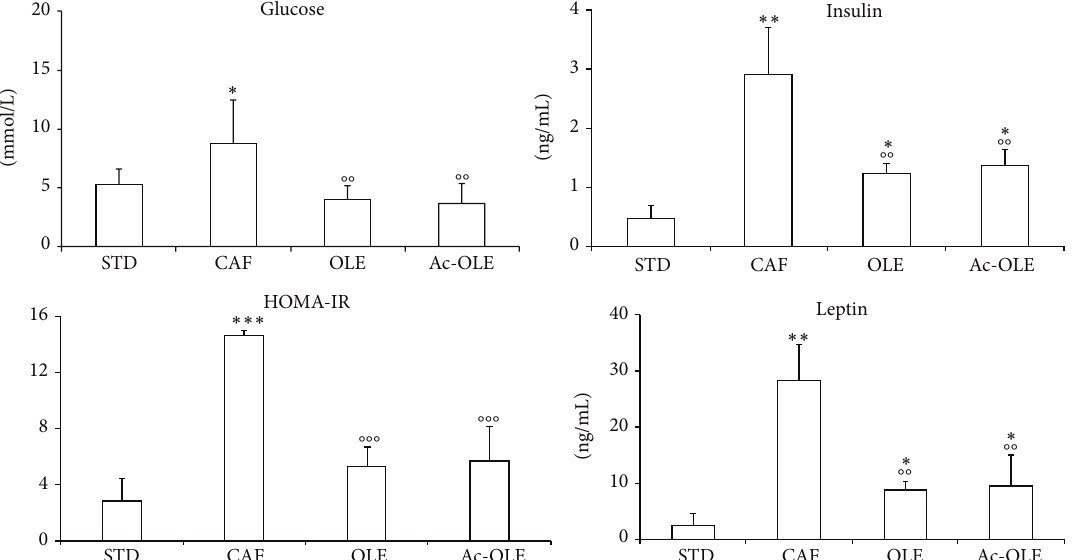
Figure 4: Effects on plasma levels of glucose, insulin, and leptin and evaluation of insulin resistance after treatment with Ole and Ac-Ole. Blood samples were collected as indicated in Methods. Glucose and hormones levels were significantly lower after treatment with Ole and Ac-Ole in animals fed with caf diet. Homeostasis model assessment of insulin resistance (HOMA-IR) was calculated as indicated in Methods. Values are mean ± SD. ∗ 𝑃 < 0.05 , ∗∗ 𝑃 < 0.01 , and ∗∗∗ 𝑃 < 0.001 compared to STD; ∘∘ 𝑃 < 0.01 and ∘∘∘ 𝑃 < 0.001 compared to